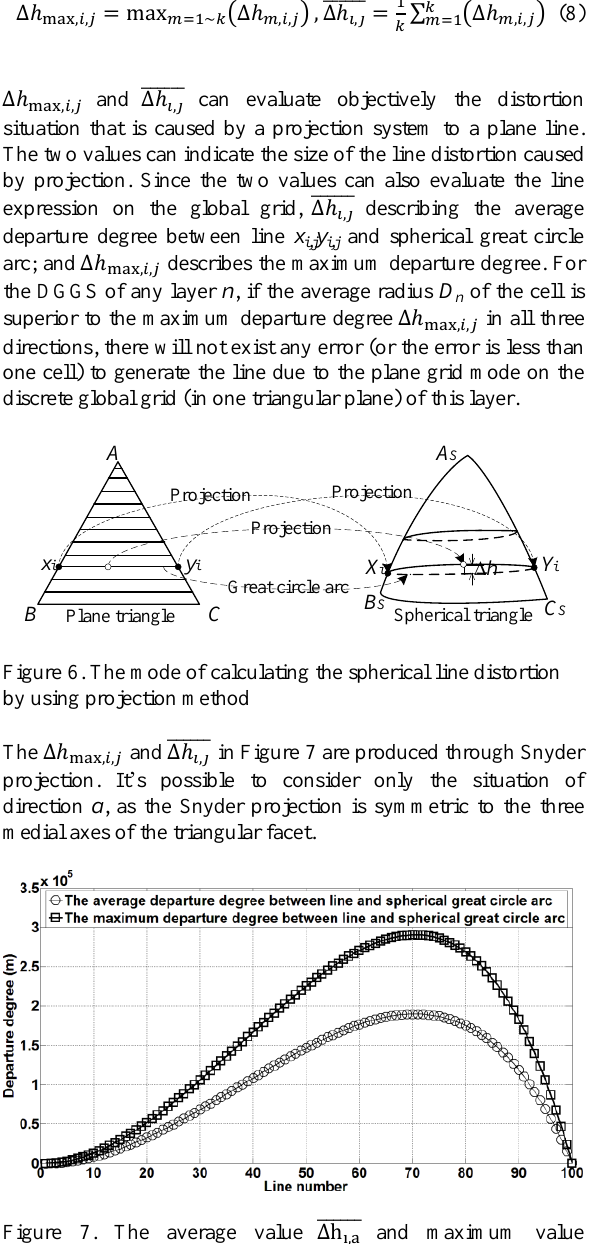
Figure 7. The average value ̅̅̅̅̅̅ and maximum value of the distance between projection points at each line and spherical great circle arc by using Snyder projection. From the Snyder projection transformation in Figure 7, the maximum distortion error of the lines produced in one triangular plane is 290.529km, and the average distortion error is 189.801km. Compared with the average radius of cells in Table 1, the conservative approach is that the vector data directly generates the line without interpolation in the 4 th layer of the discrete grid, and the eclectic approach is that the vector data directly generates the line without interpolation in the 5 th layer of the discrete